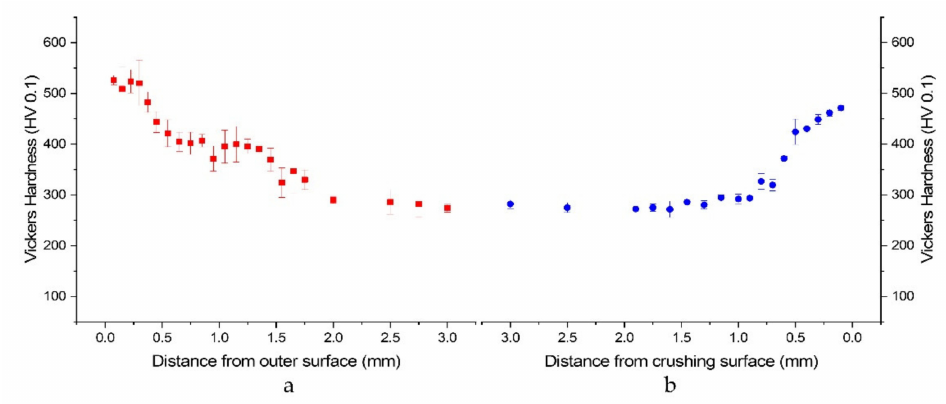
Figure 4. Variation in hardness with ( a ) distance from outer surface and ( b ) distance from crushing surface after use from worn concave of Hadfield steel.